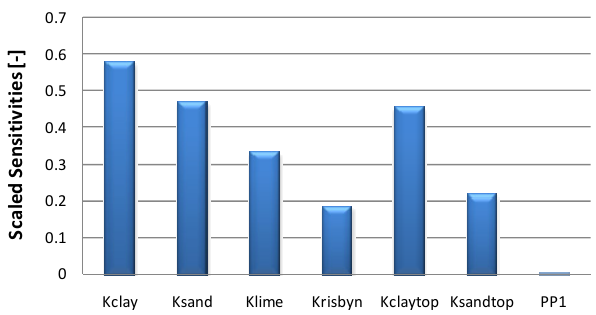
Fig. 9 Scaled Sensitivities for the parameters of the Risby model. 2 Fig. 9. Scaled sensitivities for the parameters of the Risby